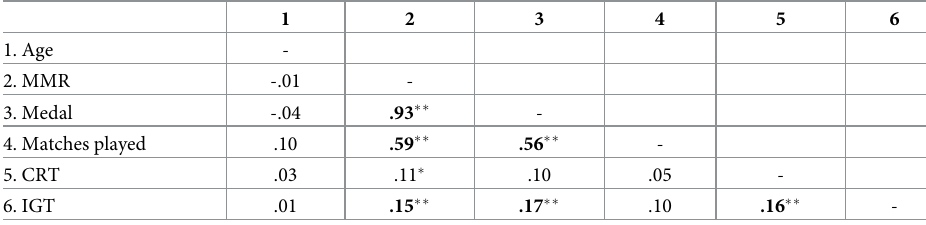
Table 2. Bootstrapped correlations between variables included in the study.